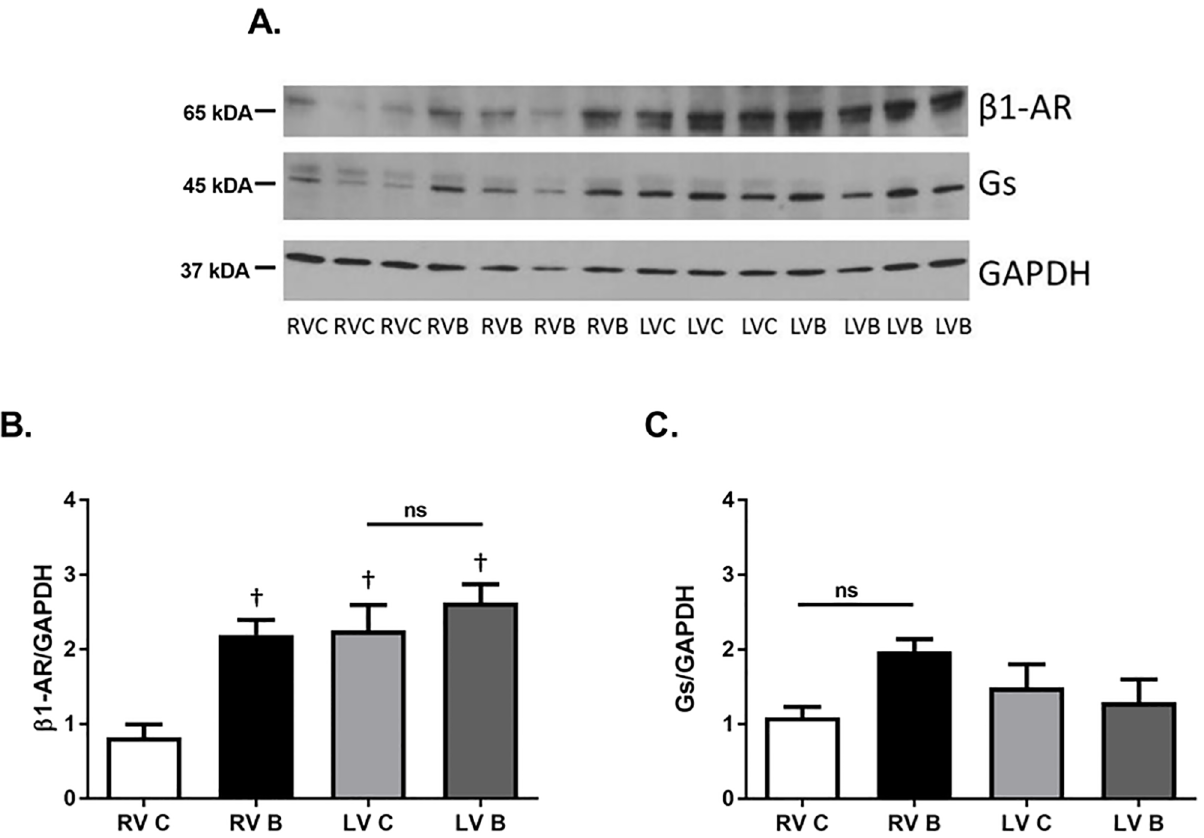
Fig 1. β 1 -AR and G s protein expression post-burn. Representative Western blots of β 1 -AR (A, B) and G s (A, C) protein expressionin right and left ventriclesseven days post-burn. Controls were nonburnedanimals. The bar graphs show the ratio of protein to GAPDH. Data are expressedas the mean ± SEM. Statistical analysiswas performed using a one-wayANOVA. n = 9–12; p < 0.00001for β 1 -AR; RV C: right ventricle control; RV B: right ventricleburned; LV C: left ventriclecontrol; LV B: left ventricleburned; †, p < 0.05vs RV C.